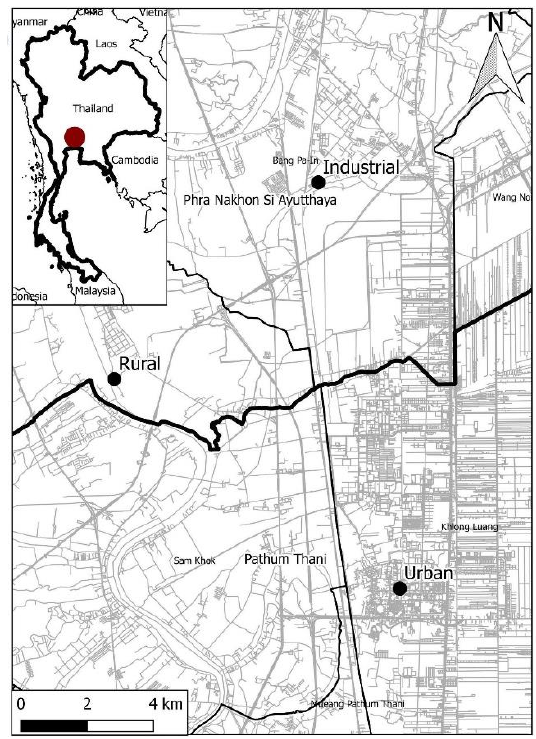
Figure 1. Sampling sites in Thailand. Notations: red point indicated the selected province in Thailand.